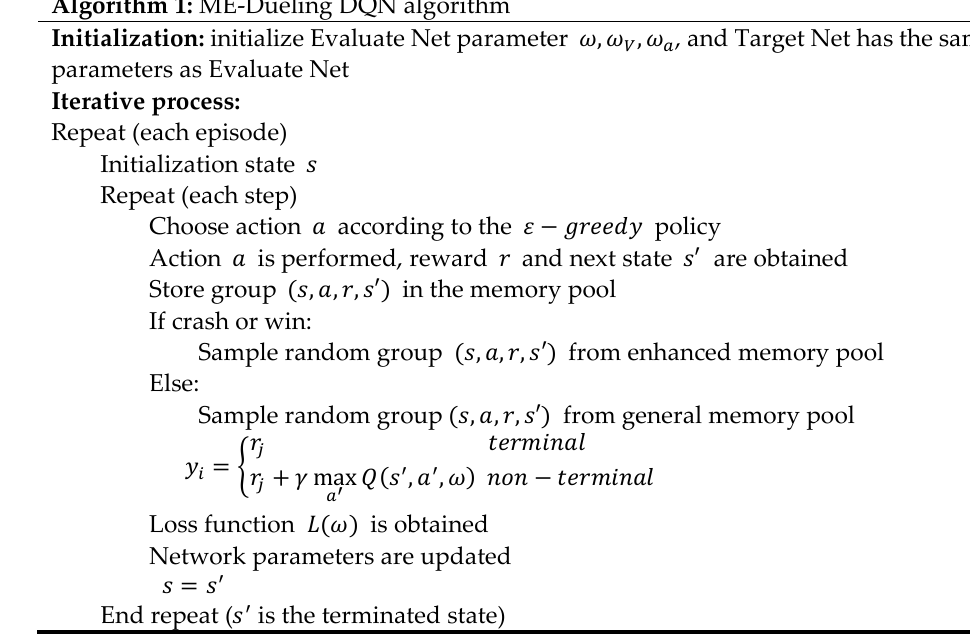
Algorithm 1: ME-Dueling DQN